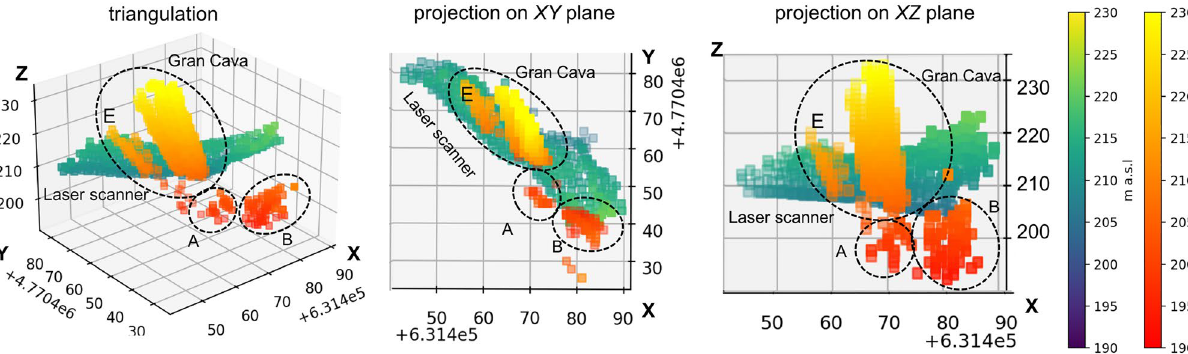
Figure 7. Results of the triangulation technique applied to the three density maps: 3D visualization (left), and the projections on plane XY (centre) and ZX (right). The colors indicate the altimetry (the orange scale for triangulation results and the blue-green scale for the Gran Cava laser scan) and the x and y coordinates are reported in the reference system EPSG:32632. The detector is located at about 185 m a.s.l.. The biggest area is identified with the Gran Cava at a relative altitude of about 20 m. The cavities A and B are not present in the cartography’s map of the